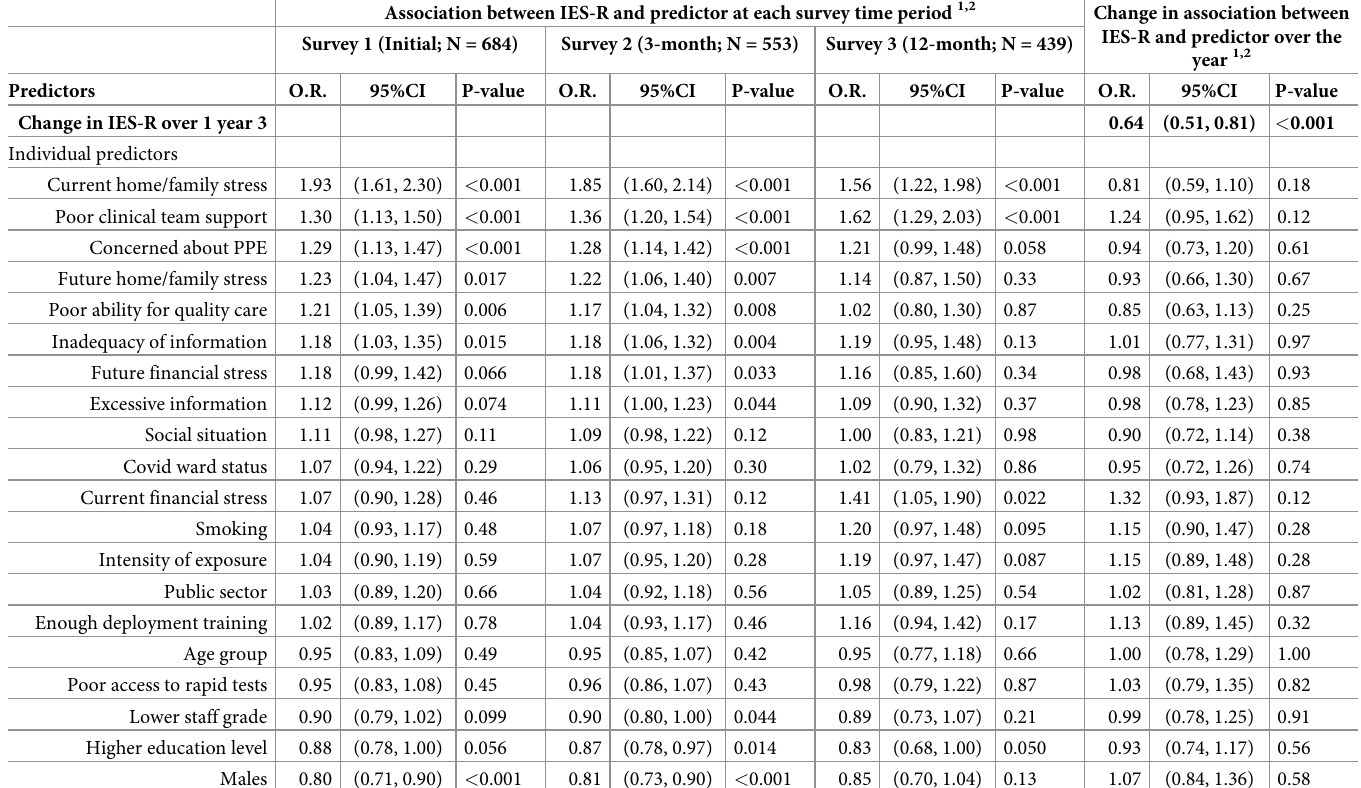
Table 5. Relative impact of predictors on Impact of Events–Revised (IES-R) score in responses over the year of surveys. Association between IES-R and predictor at each survey time period 1,2